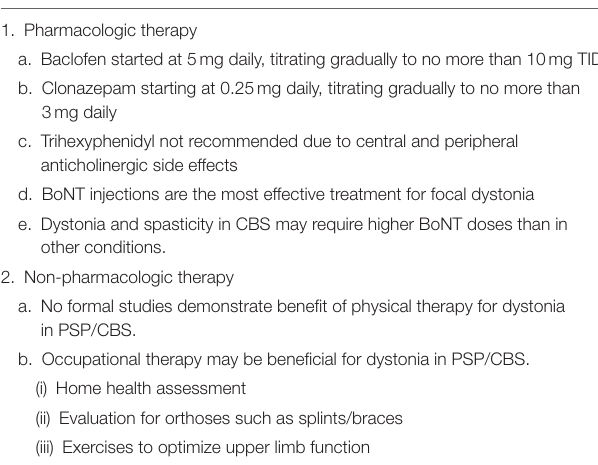
TABLE 3 | Management of dystonia in